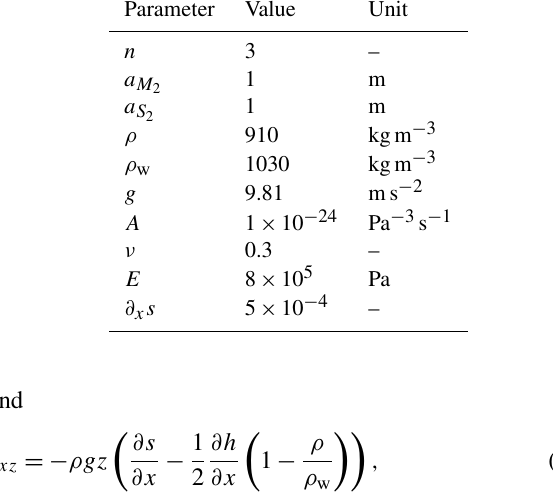
Table 1. Choice of parameters used in Eq. (18) to produce Fig. 2. Parameter Value